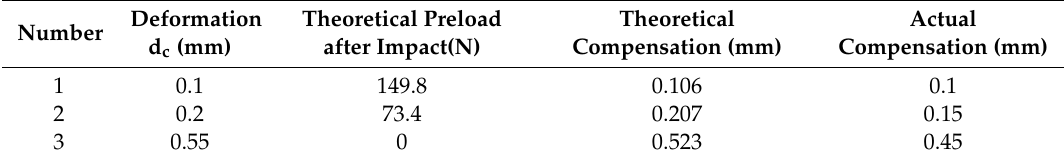
Table 3. Deformation dc of a rotor and compensation thickness.